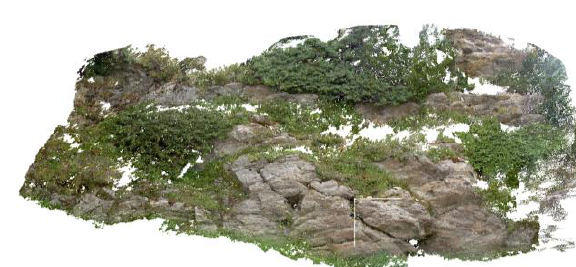
Figure 6. Agisoft PhotoScan GoPro dense point cloud